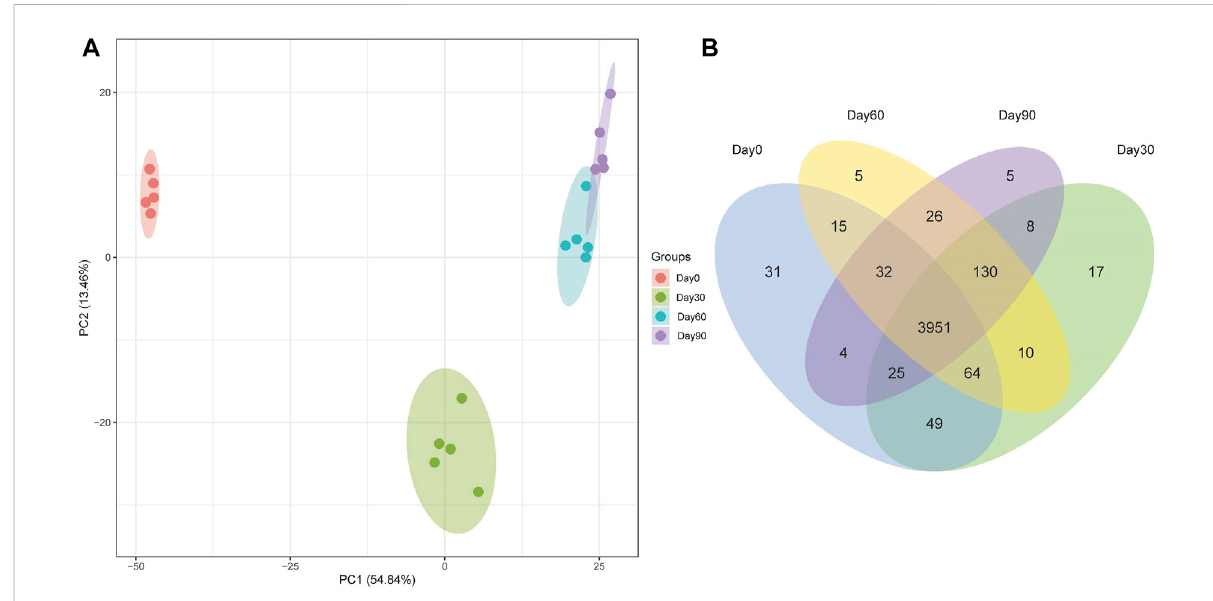
FIGURE 2 PCA scores plot (A) and Venn Diagram (B) of proteins identi fi ed in rumen epithelium at the age of day 0, day 30, day 60, and day